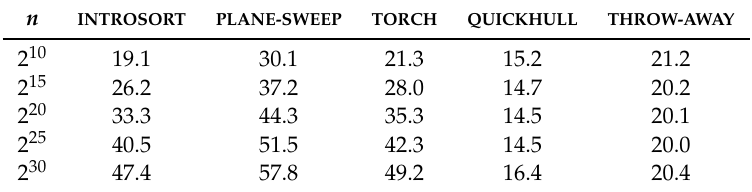
Table 10. The number of coordinate moves performed by the competitors [divided by n ] for the square data